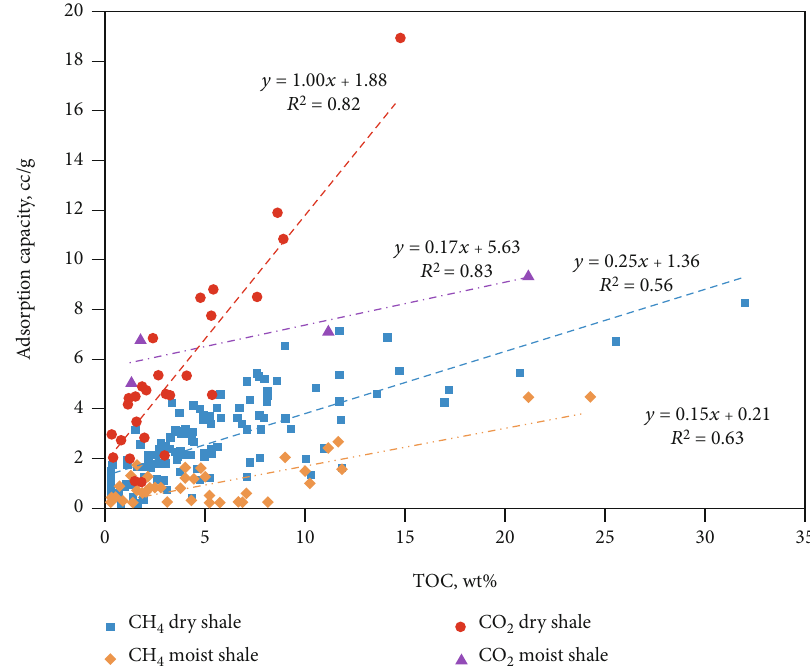
Figure 2: Correlation between TOC and CH selected from literature [22, 29, 35 –